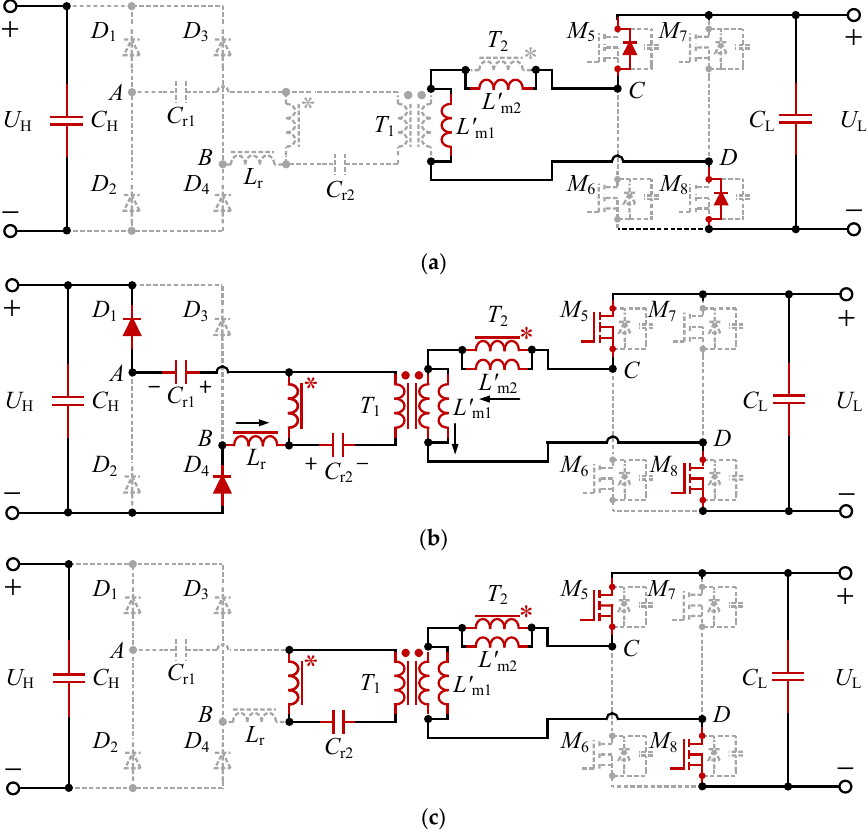
Figure 4. Equivalent circuits in step-up mode: ( a ) Interval A; ( b ) Interval B; ( c ) Interval C (The symbols of “*” are dotted terminals of T 2 ).